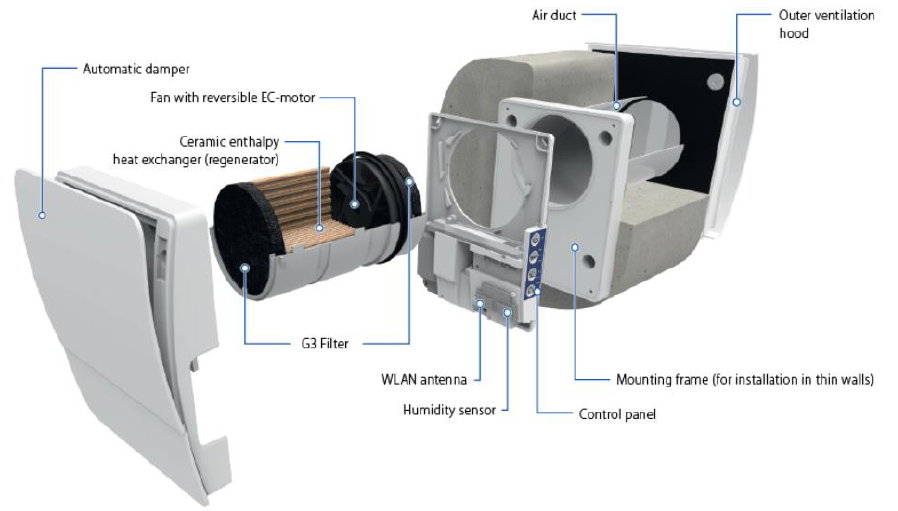
Figure 1. Wall-type ventilation unit used in the analysis [58].